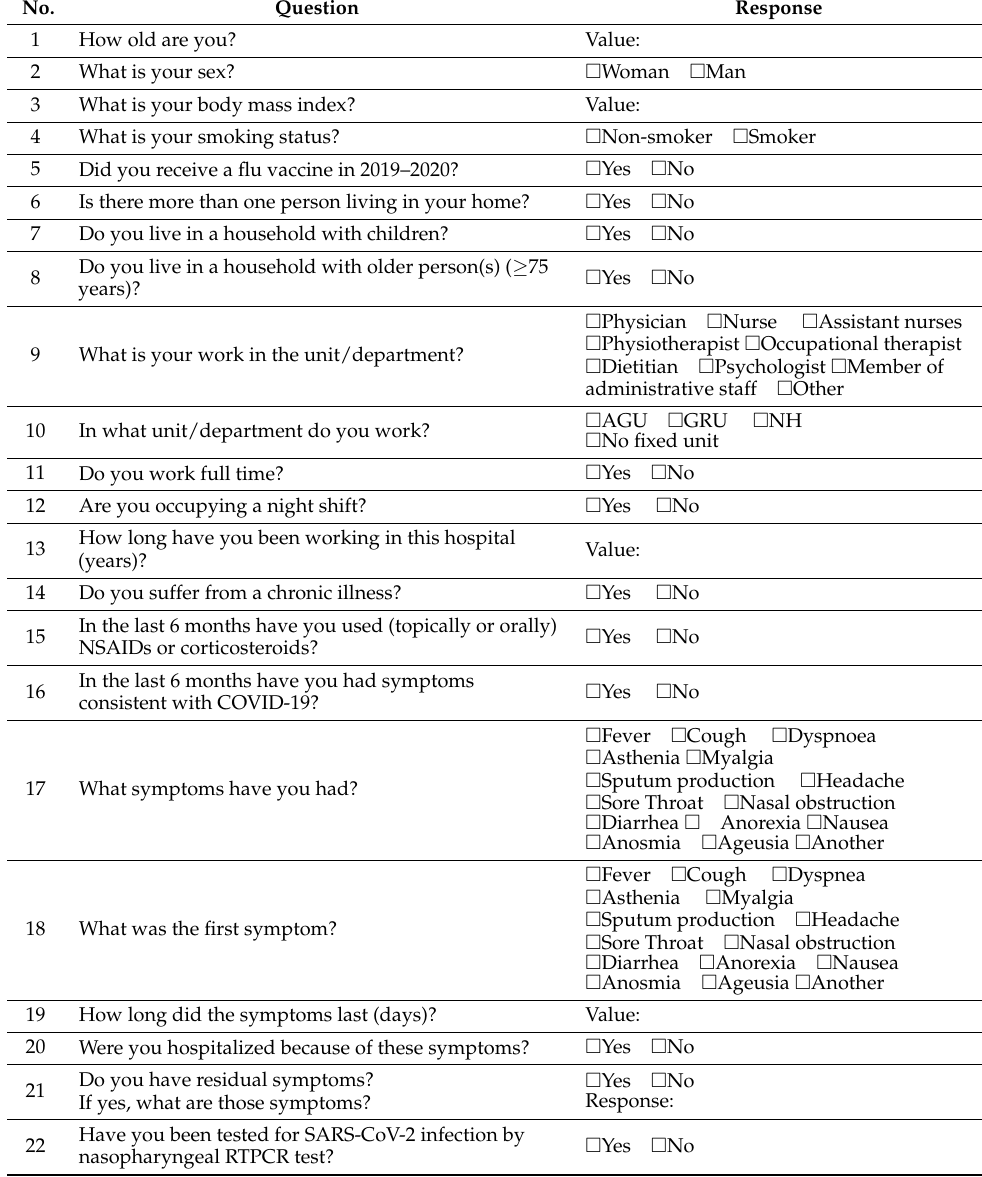
Table 1. Questionnaire of the